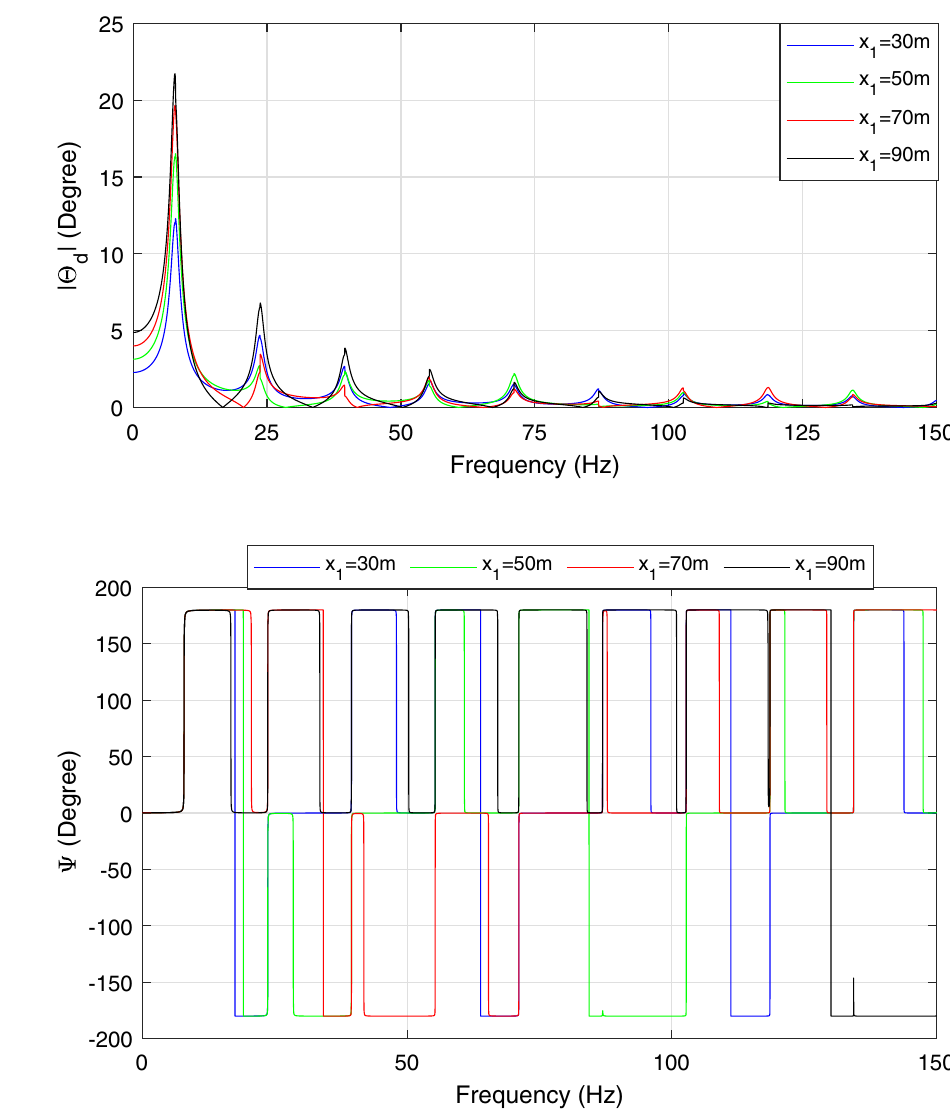
Fig. 8 Phase frequency response magnitude for different reamer